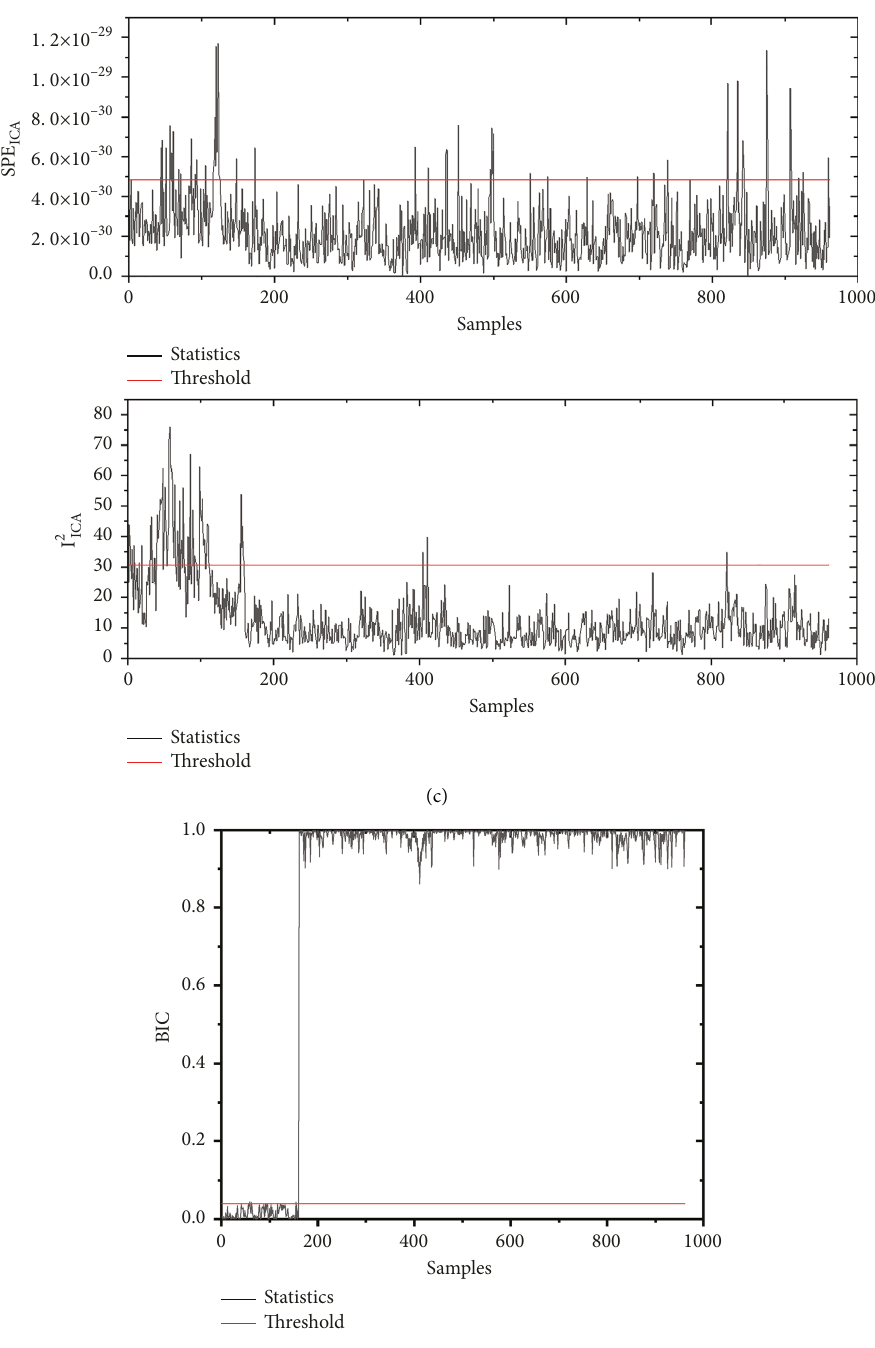
Figure 6: Monitoring results of faults in the CSTR process: (a) PCA; (b) KPCA; (c) ICA; (d)